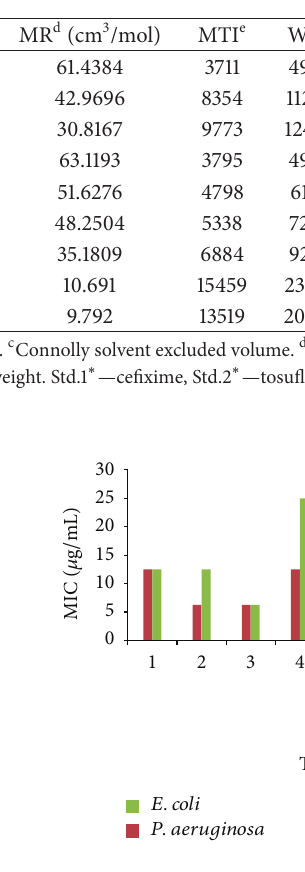
Table 3: Calculation of various molecular properties of the synthesized benzamide substituted Mannich bases.